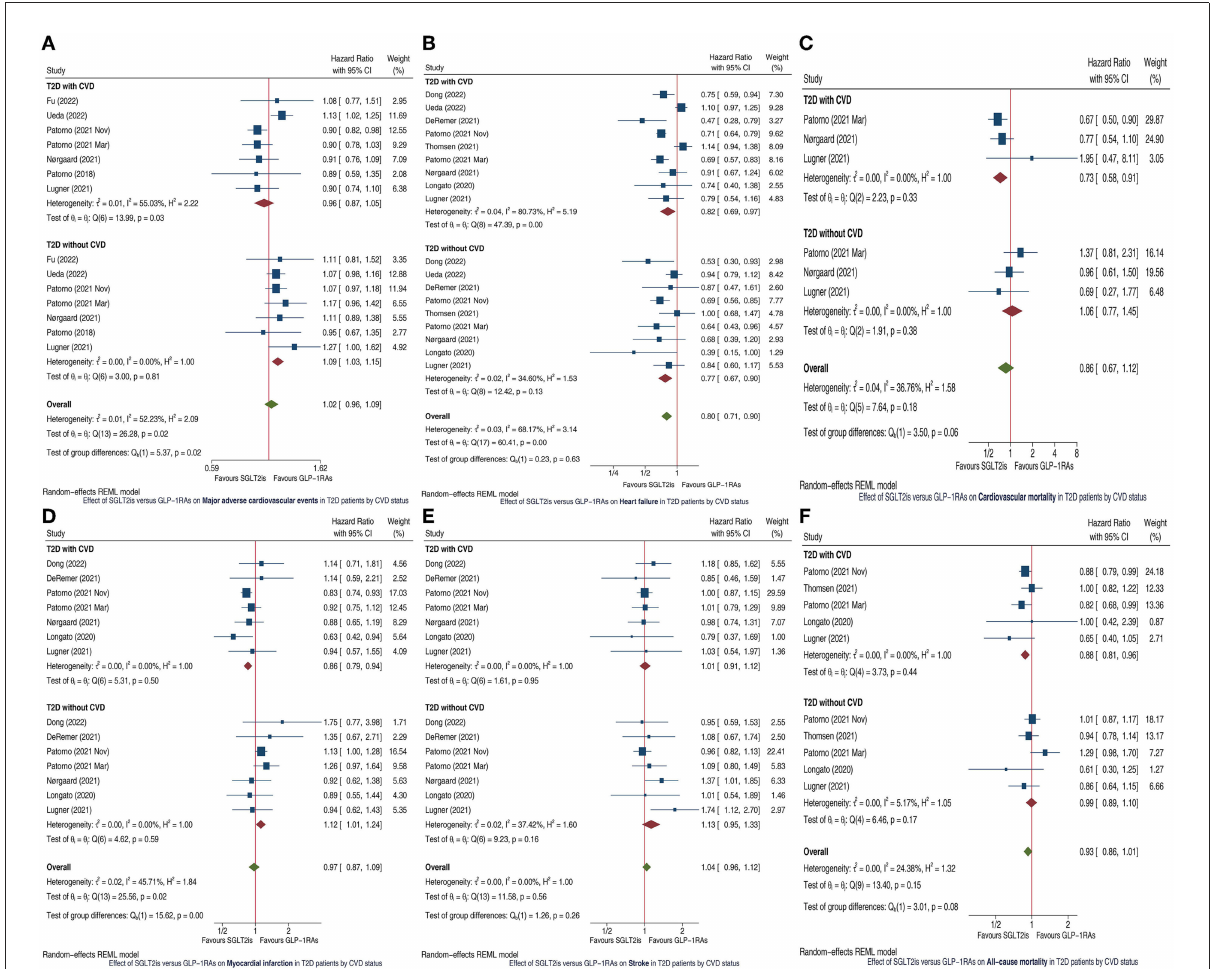
FIGURE1 Forest plots showing the effects of SGLT2is vs. GLP-1RAs on major adverse cardiovascular events (A) , heart failure (B) , cardiovascular mortality (C) , myocardial infarction (D) , stroke (E) , and all-cause mortality (F) in T2D patients by CVD status. SGLT2is, sodium-glucose cotransporter 2 inhibitors; GLP-1RAs, glucagon-like peptide-1 receptor agonists; T2D, type 2 diabetes; CVD, cardiovascular disease; CI, confidence